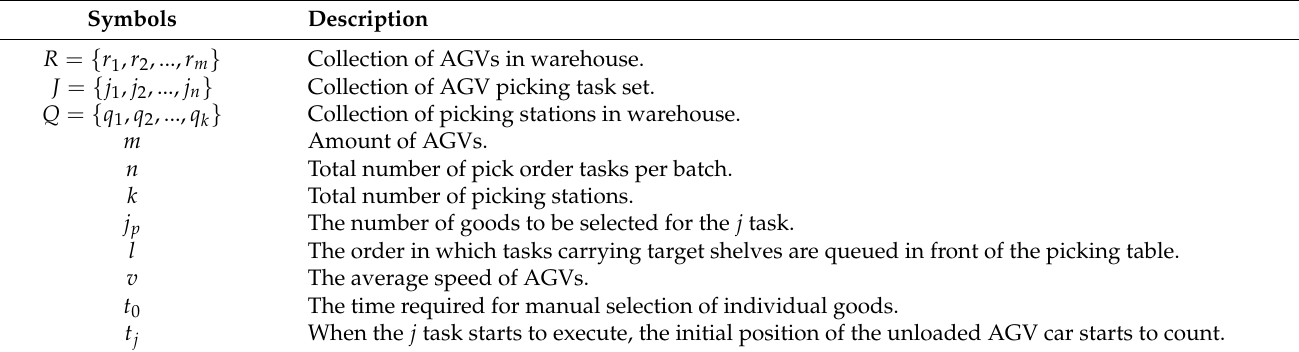
Table A4. Symbols description of model static picking order to determine the target shelf (see Section